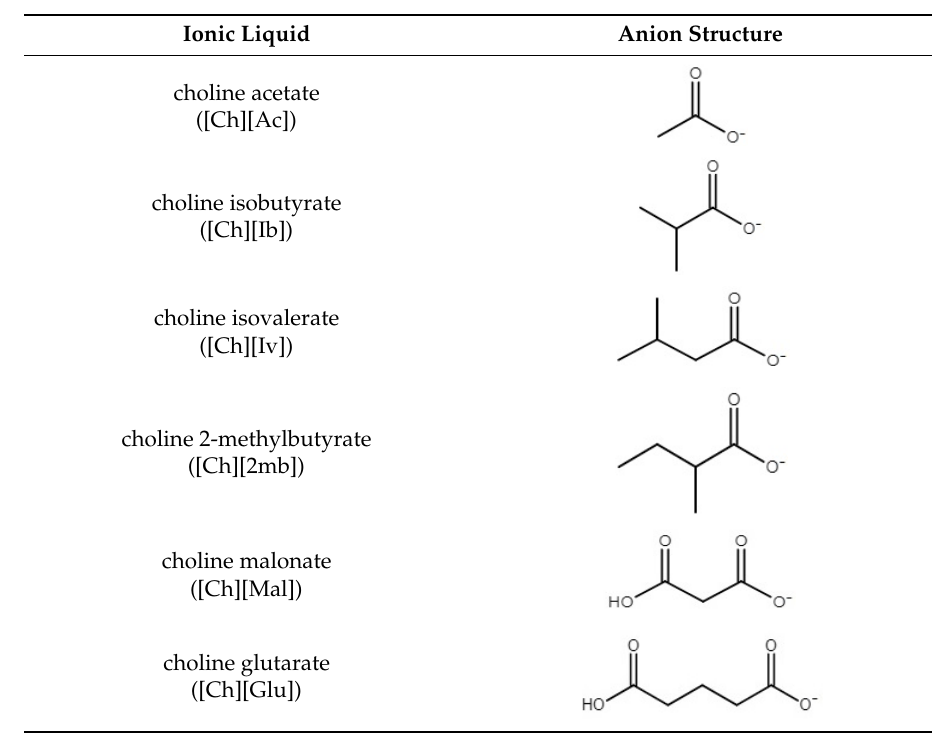
Table 1. Choline ionic liquids (ILs) used in this research.